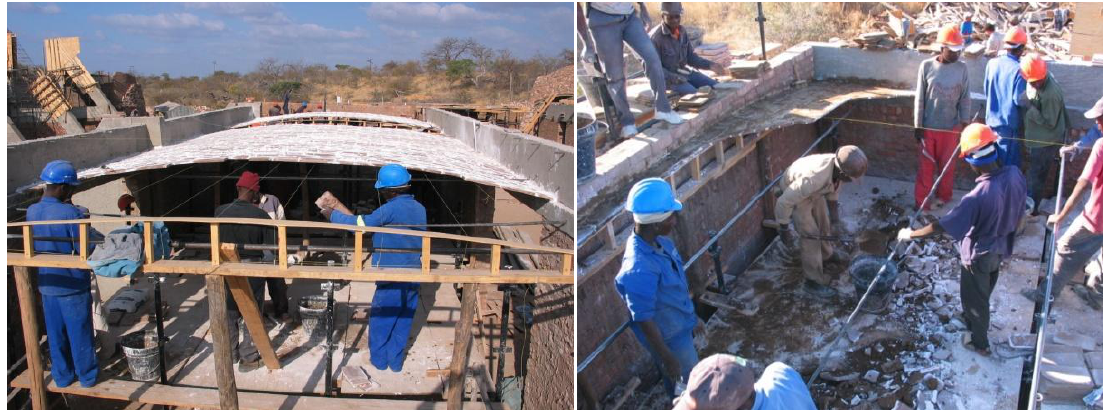
Figure 1 The learning and failure